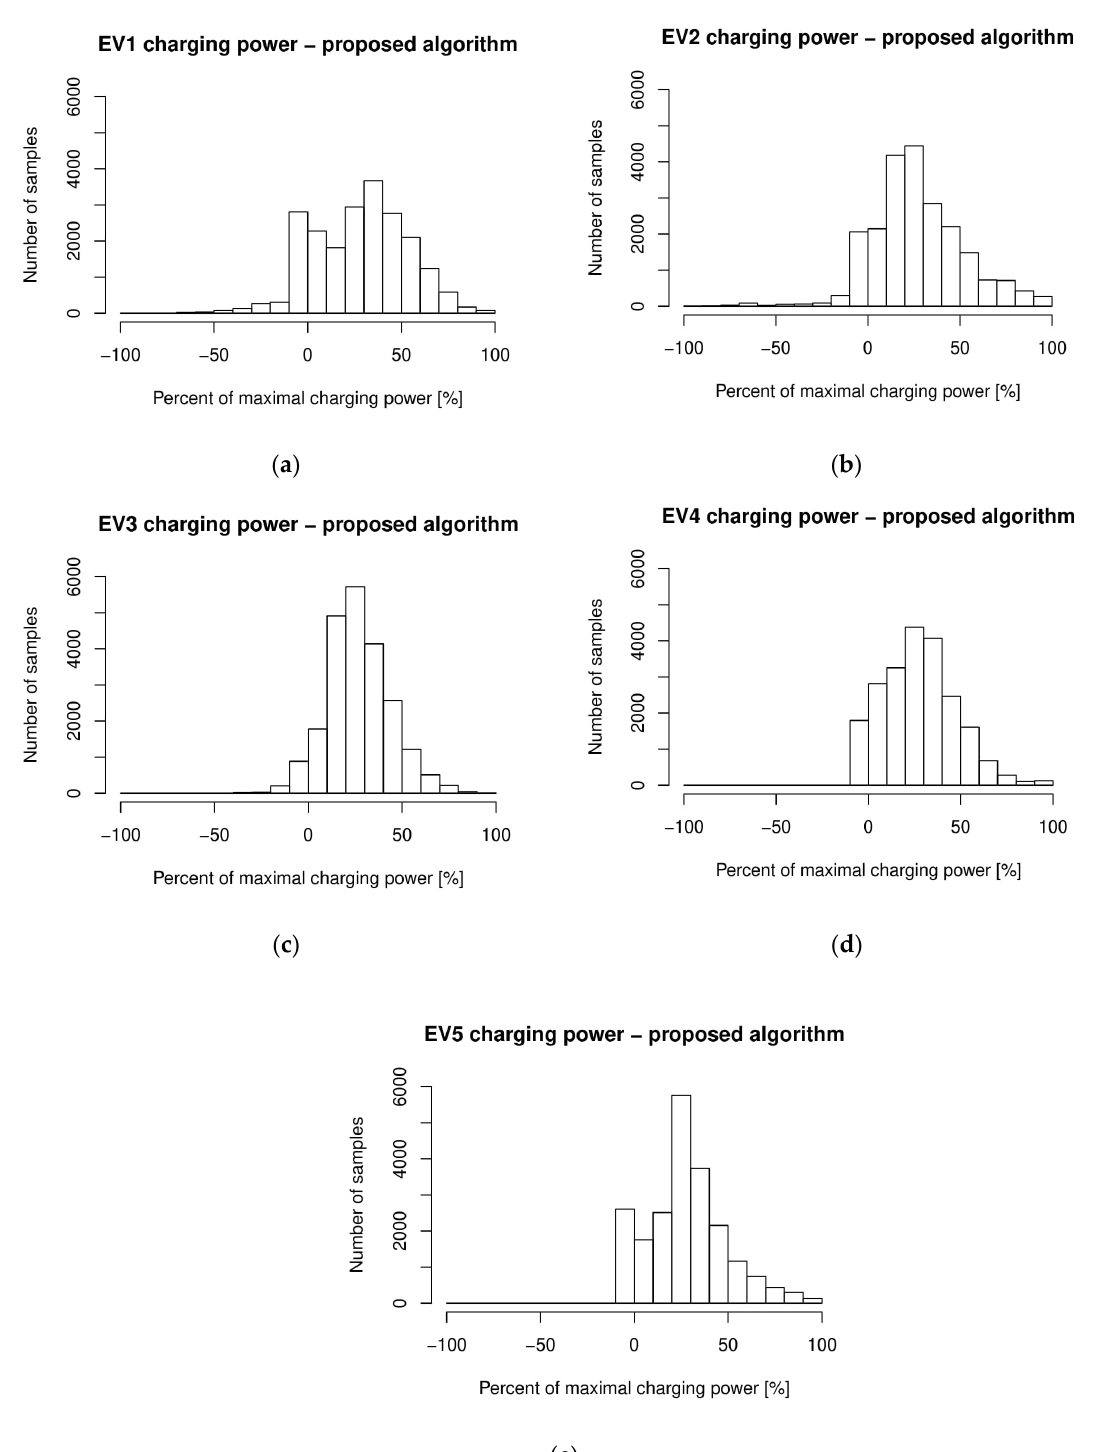
Figure 10. Histograms of charging/discharging power (6 min sampling rate) of every EV over the course of 300 simulated situations. ( a ) EV1, ( b ) EV2, ( c ) EV3, ( d ) EV4, ( e ) EV5—charging power with the utilization of the proposed algorithm.